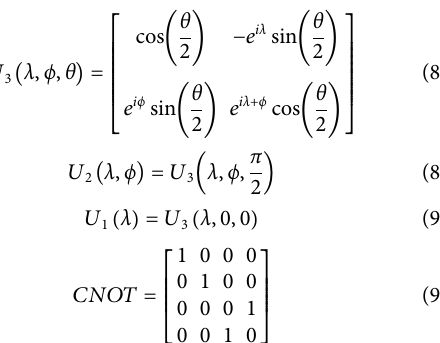
FIGURE 7 Scheme ofthevariational circuitin (Lubaschet al.,2020).The quantum nonlinear processing unit (QNPU) takes as input r copies of the solution vector, generated by the ansatz U ( θ ) . Then, the QNPU applies the operators O j in Eq. 92 as quantum operators. The circuit ’ s output comes from the measurements of the ancilla qubit and corresponds to the required cost function